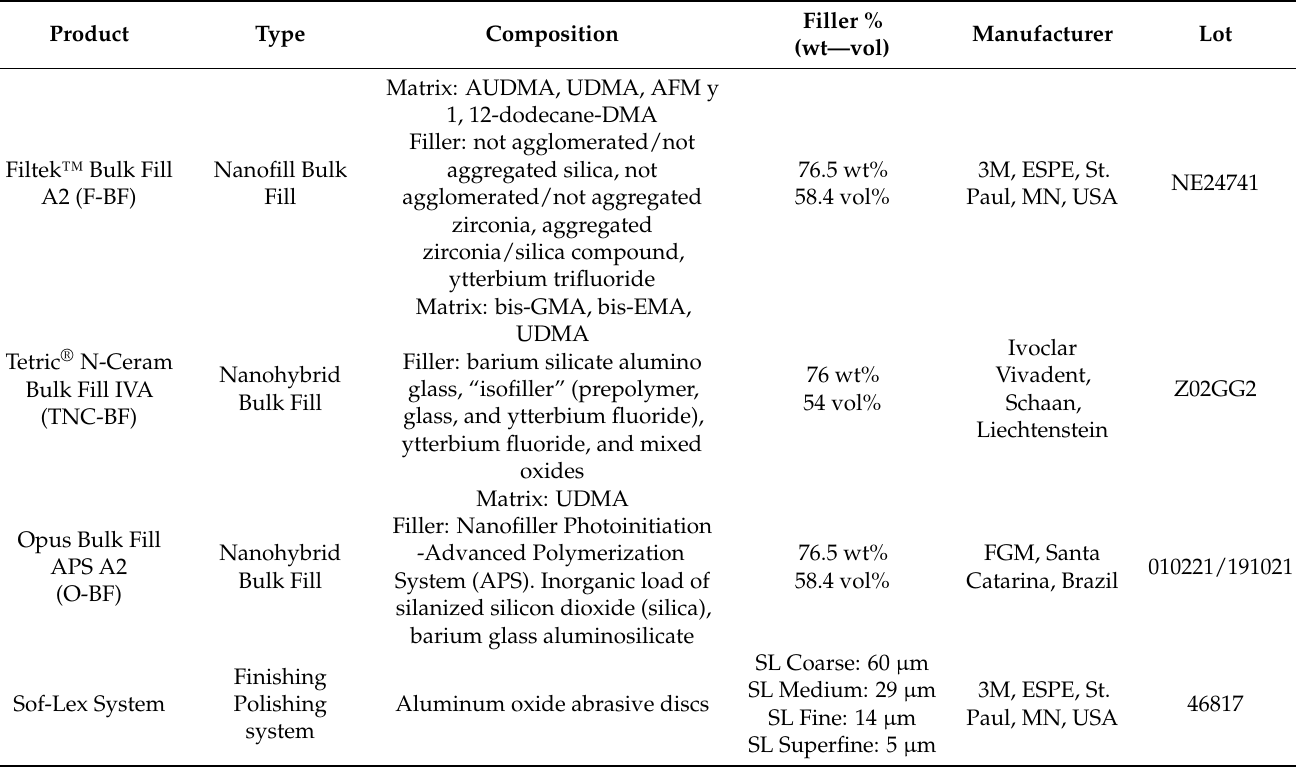
Table 1. Technical profile of products used.